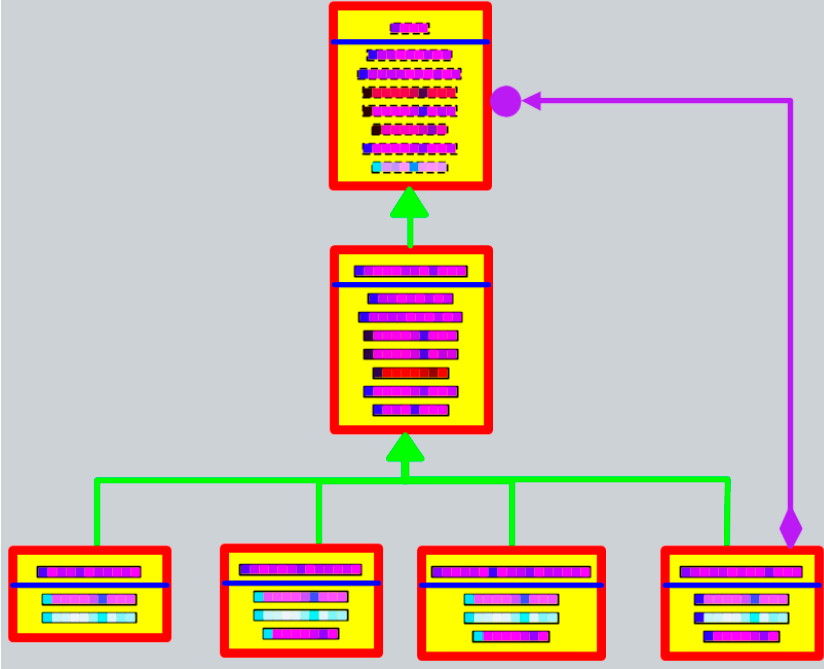
Figure 6. Second-level subsystem